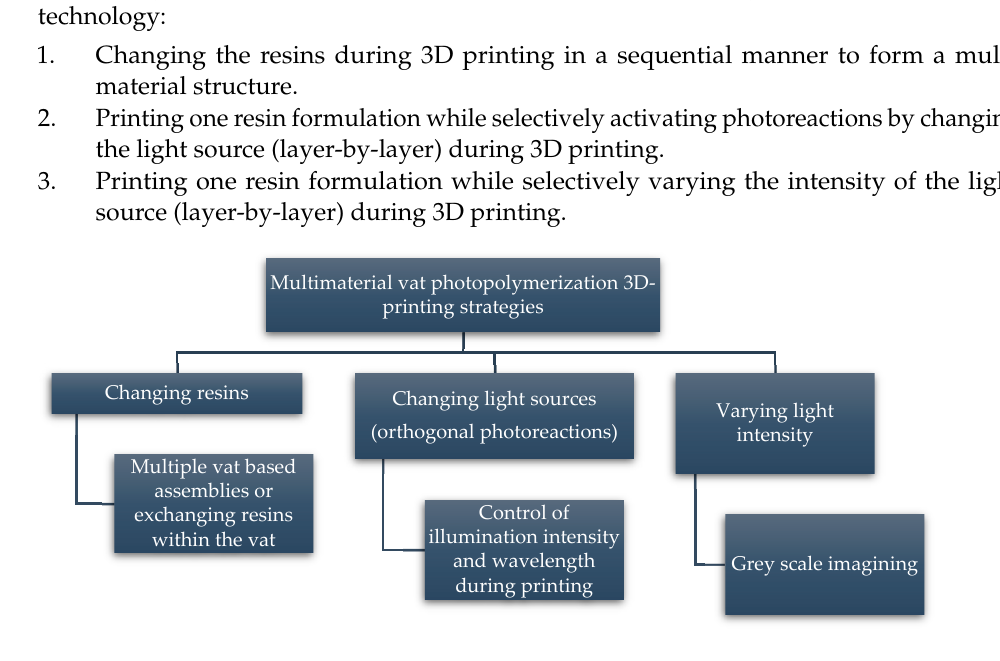
Figure 25. Strategies for multi-material vat photopolymerization 3D printing.